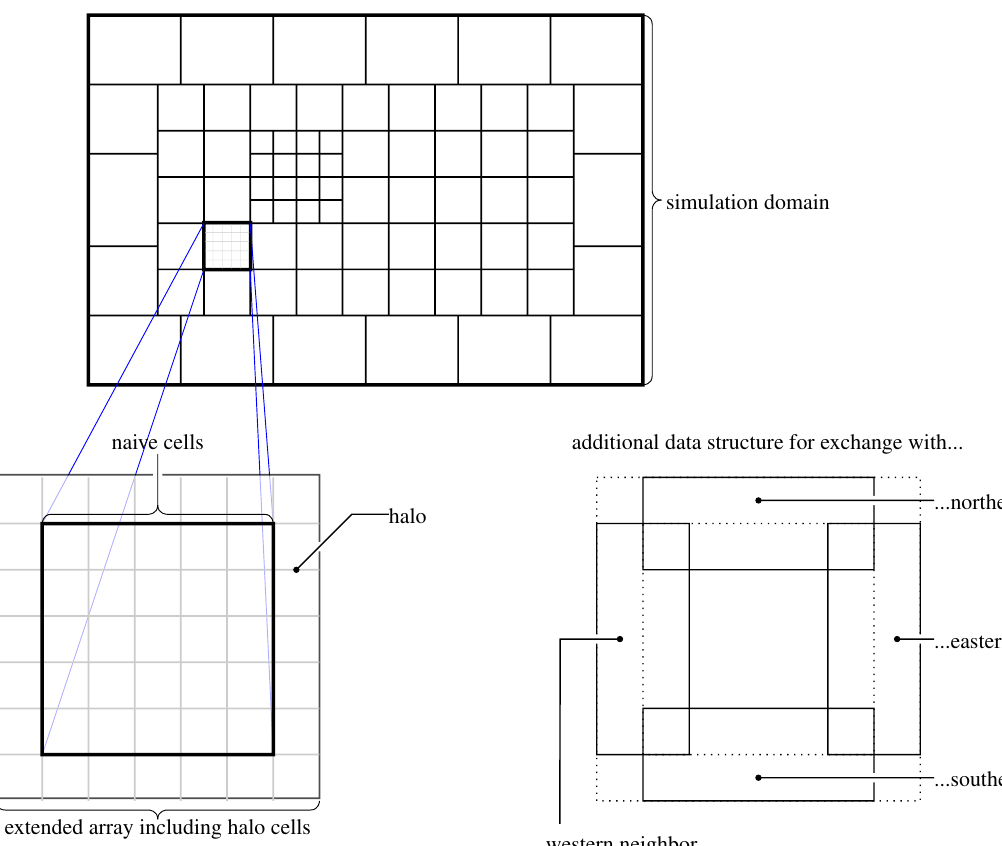
Fig. 1. Illustration of block structure for simulation domain as well as one generic block in MUSCAT.